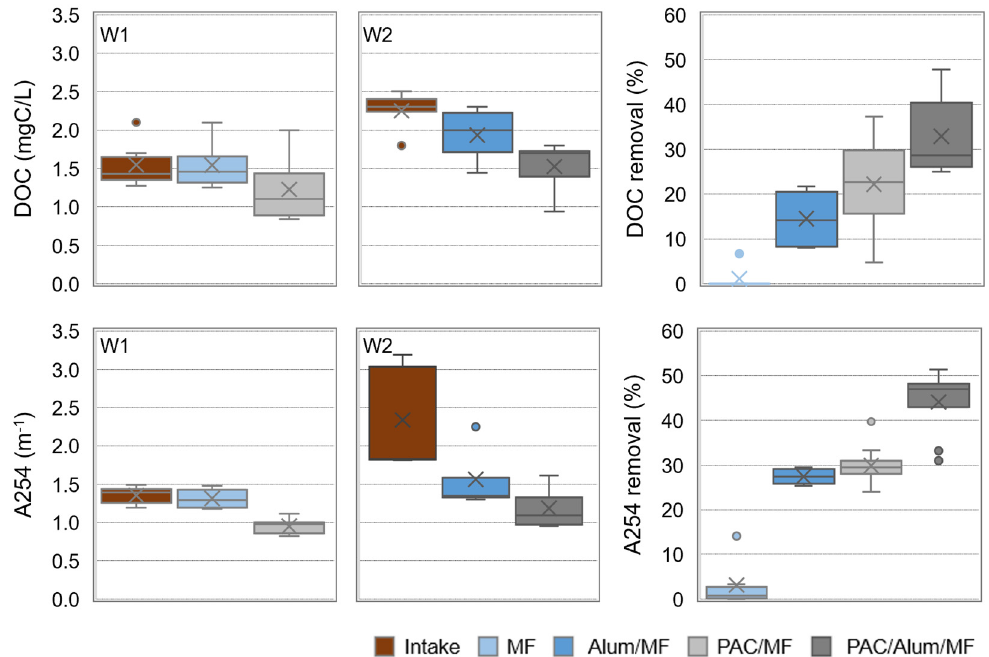
Figure 7. NOM content, as DOC and A254, in pilot intake (W1 or W2) and permeate waters after MF and PAC/MF (for W1, 7–13 mg/L PAC) or Alum/MF and PAC/Alum/MF (for W2, 2–3 mg/L Al 2 O 3 and 4–13 mg/L PAC) and respective removals (box plots with maximum, P75, average, median, P25 and minimum values; little circles are outliers).